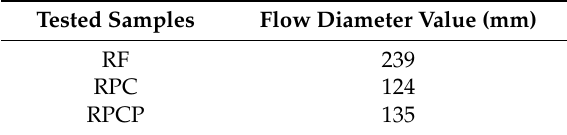
Table 2. Flow diameter values of reference sample (RF) and fiber cement mixtures (RPC and RPCP).